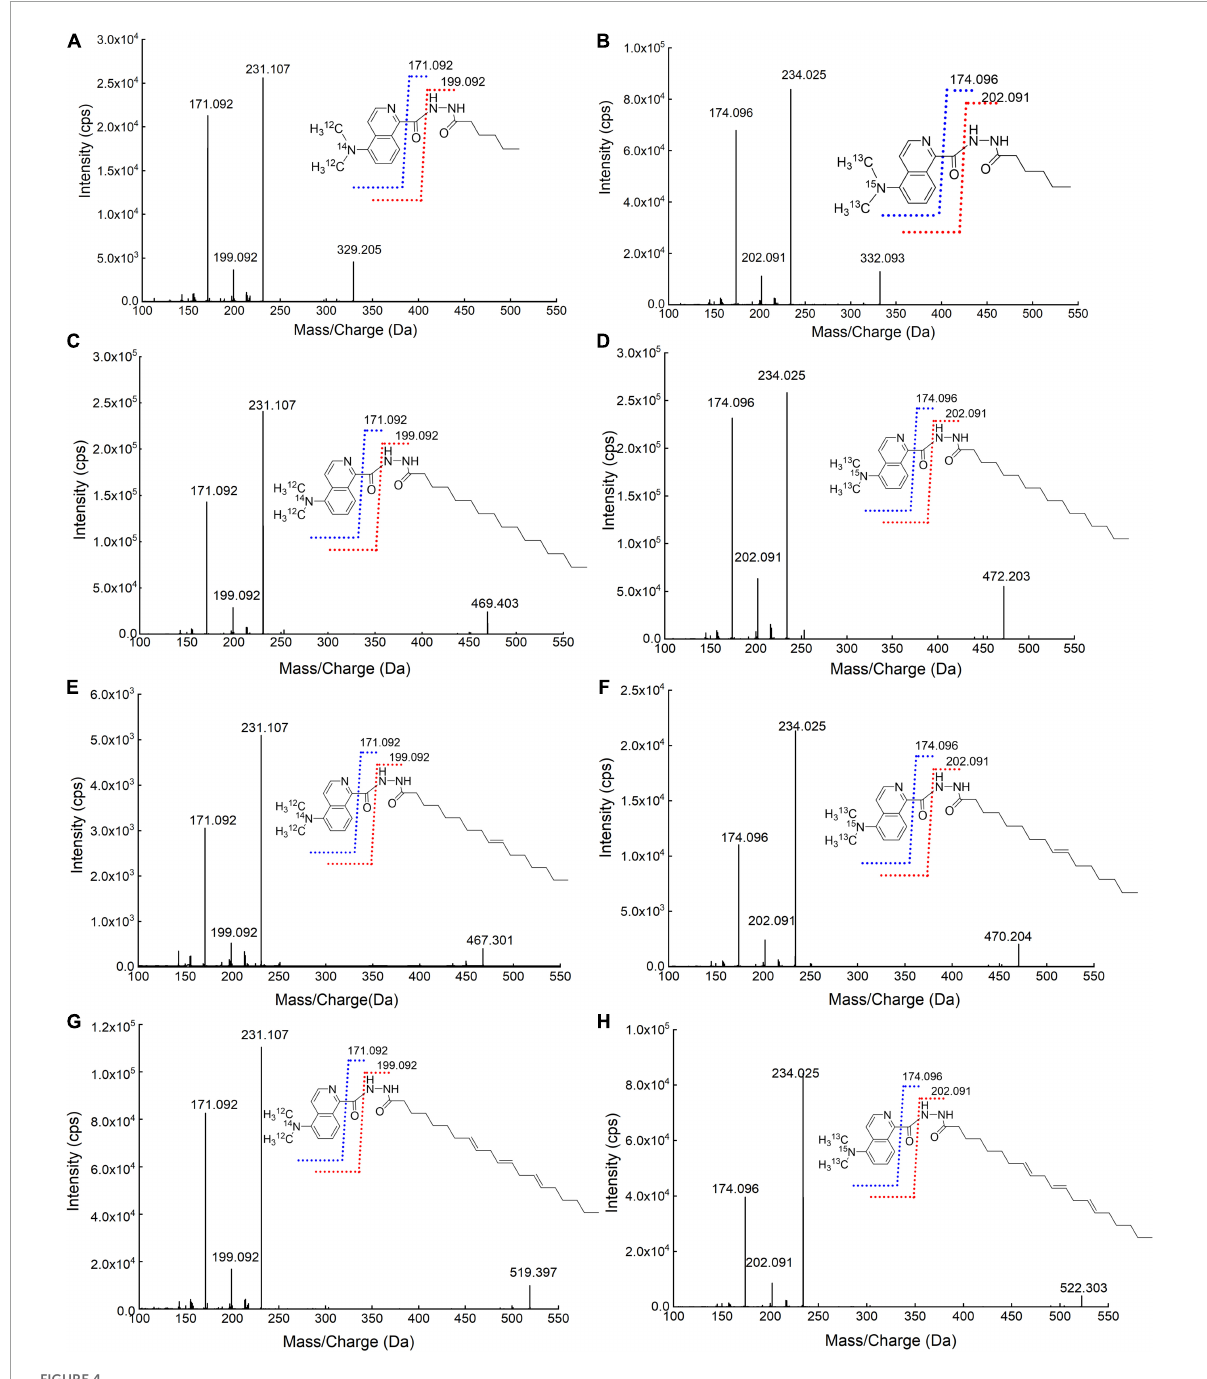
FIGURE4 Mass spectrometry (MS)/MS spectra of (A) DMAQ- 12 C/ 14 N-derivatized hex (C6:0); (B) DMAQ- 13 C/ 15 N-derivatized hex (C6:0); (C) DMAQ- 12 C/ 14 N-derivatized pal (C16:0); (D) DMAQ- 13 C/ 15 N-derivatized pal (C16:0); (E) DMAQ- 12 C/ 14 N-derivatized 9-Hex (C16:1); (F) DMAQ- 13 C/ 15 N-derivatized 9-Hex (C16:1); (G) DMAQ- 12 C/ 14 N-derivatized-8, 11, 14-Eic (C20:3), and (H) DMAQ- 13 C/ 15 N-derivatized-8, 11, 14-Eic (C20:3).